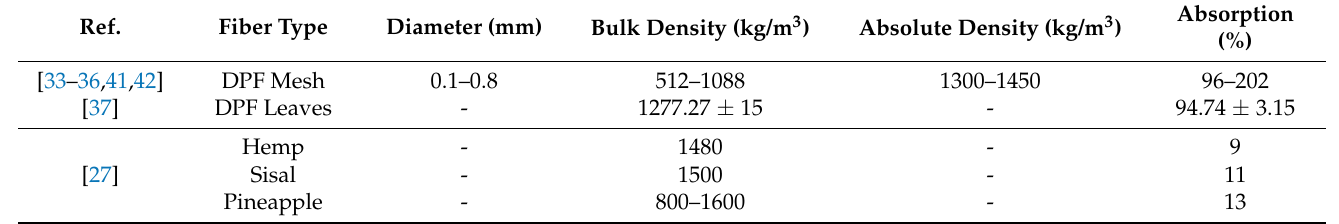
Table 3. Physical properties of DPF compared to other agricultural fibers.